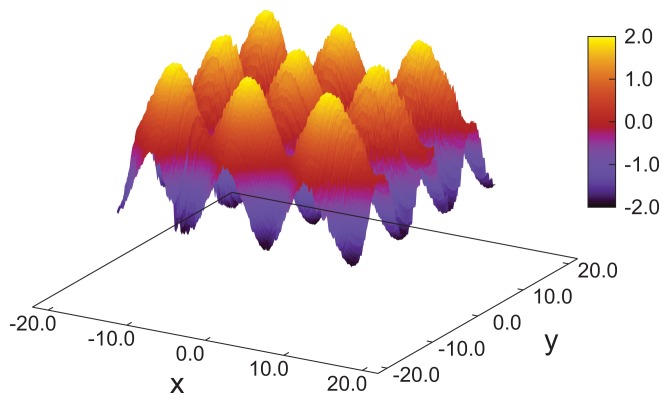
As Figure 2, but for ɛ3 = 0.90 in the blue phase.